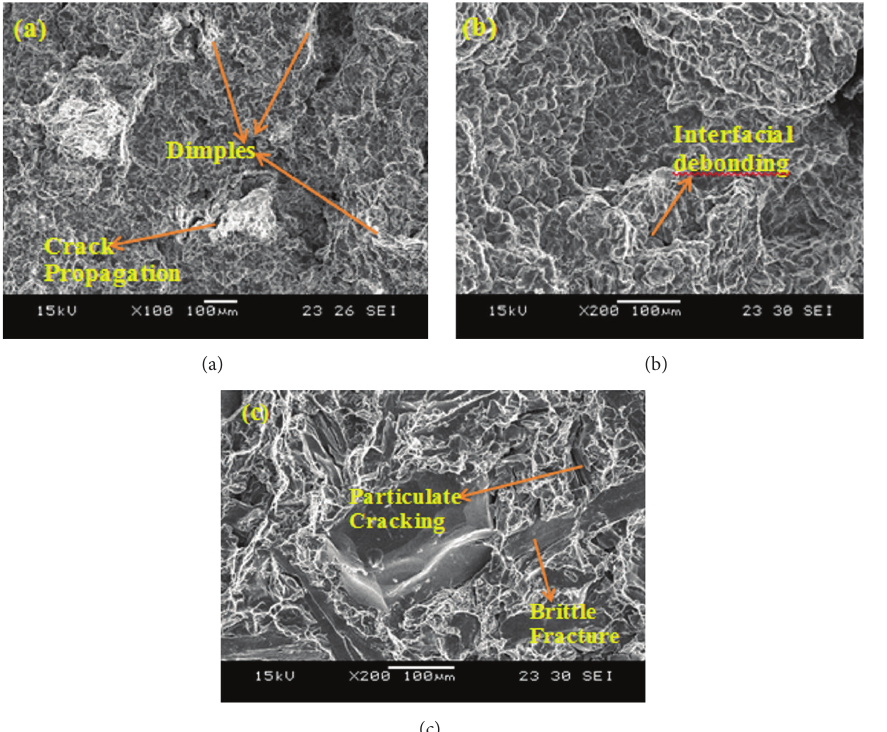
Figure 8: SEM fractography images of Al 7075/TiB 2 /Gr hybrid composites: (a) Al 7075/0% wt. TiB 2 /1% Gr, (b) Al 7075/3% wt. TiB 2 /1% Gr, and (c) Al 7075/6% wt. TiB 2 /1% Gr.